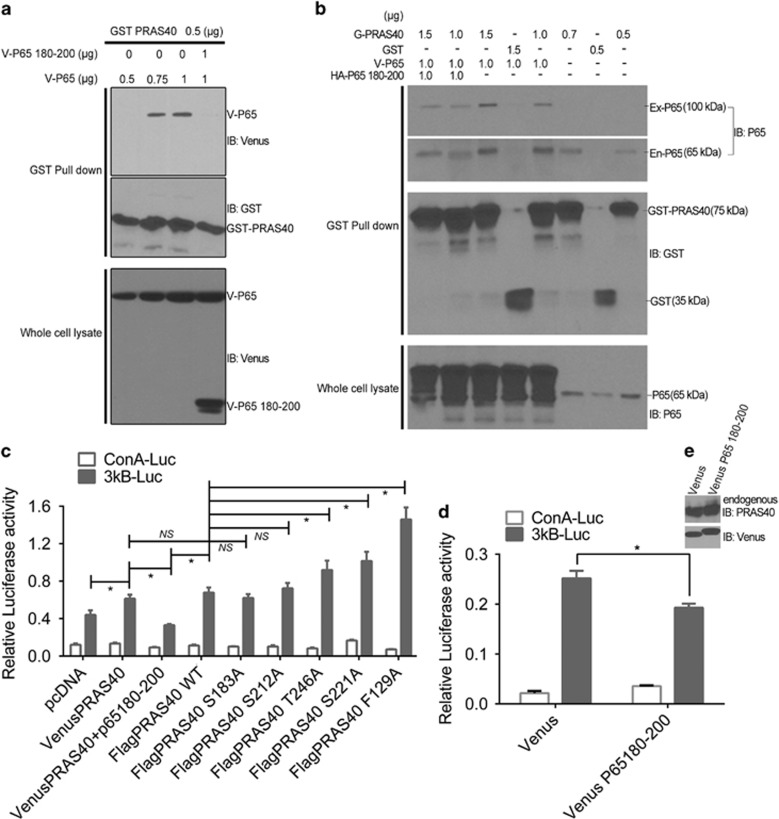
p65 180-200 peptide disrupts the PRAS40–P65 interaction and regulates NF-κB transcriptional activity. (a) The Venus-tagged p65 180-200 peptide could disrupt the PRAS40–P65 association (lane 4 vs lane 3). There is no significant difference between the cells co-transfected with GST PRAS40 DNA and 0.75 or 1 μg of Venus-P65 (lane 2 vs lane 3). (b) HA-tagged p65 180-200 could disrupt the PRAS40 association with exogenously expressed or endogenous p65 (lane 1 vs lane 3; lane 2 vs lane 5). The remaining blots served as negative controls. The blot of the Ex-/En-P65 shows the exogenous and endogenous P65 expression, respectively. (c) In all, 46.3% of NF-κB transcriptional activity in the 3κB-Luc group cells with PRAS40 overexpression was reduced by the 180-200 fragment of p65 (P<0.001). The mutants of PRAS40 increased the NF-κB transcription activity comparing to the pcDNA control group. There are no significant differences of relative activity between the groups of ConA-Luc. NS=P>0.05, *P<0.01. (d) The p65 180-200 peptide significantly reduced the basal NF-κB transcription activity in cells with endogenous PRAS40 expression. *P<0.01. (e) The 3κB-Luc group cells with Venus and Venus-P65 180-200 used in the above experiment (d) were utilized to validate the transfection efficiency. Flag was used as the referral control of transfection because flag tag was included in the Venus tag vector in this study.